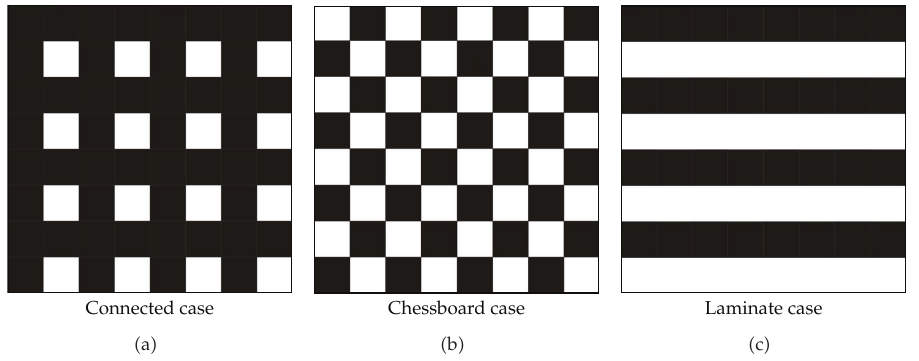
Figure 2: The three special cases when the local conductivity only takes two